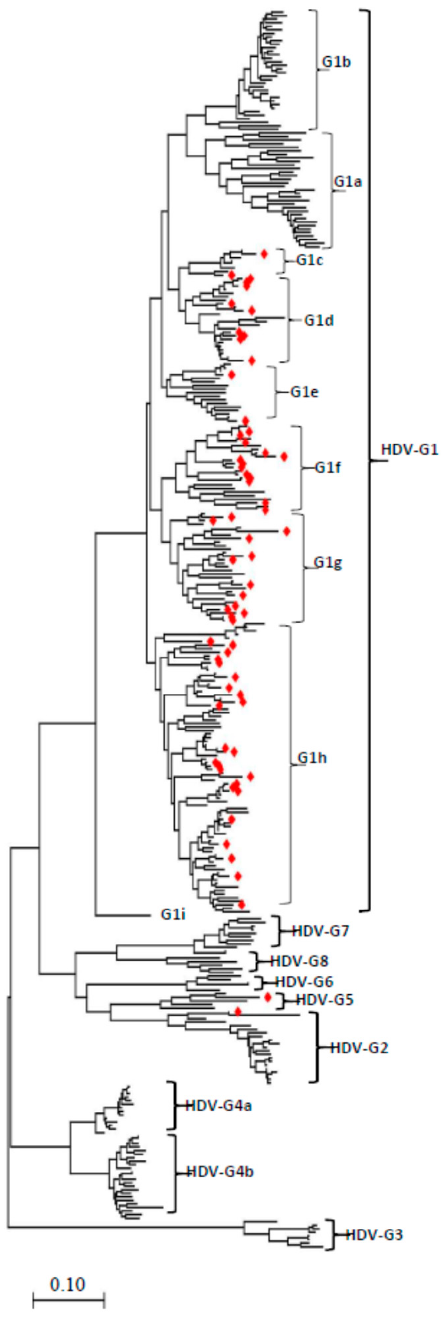
Figure 1. Phylogenetic tree based on 348 human HDV sequences of 1678 nucleotides in length. The tree was constructed using the Maximum Likelihood method in the MEGA-11 software. The Maximum Likelihood method and Tamura Nei model were used to infer the evolutionary history. Initial trees for the heuristic search were automatically obtained by applying Neighbor Join and BioNJ algorithms to a matrix of pairwise distances estimated using the Tamura Nei model and selecting the topology with a superior log-likelihood value. The scale bar refers to a phylogenetic distance of 0.10 nucleotide substitution at each position. The viruses marked in red diamonds represent strains isolated from Kyrgyzstan. Strains are identified in a format as (GenBank ID: virus name (country-year of collection-genotype, and detailed in the Supplementary Figures